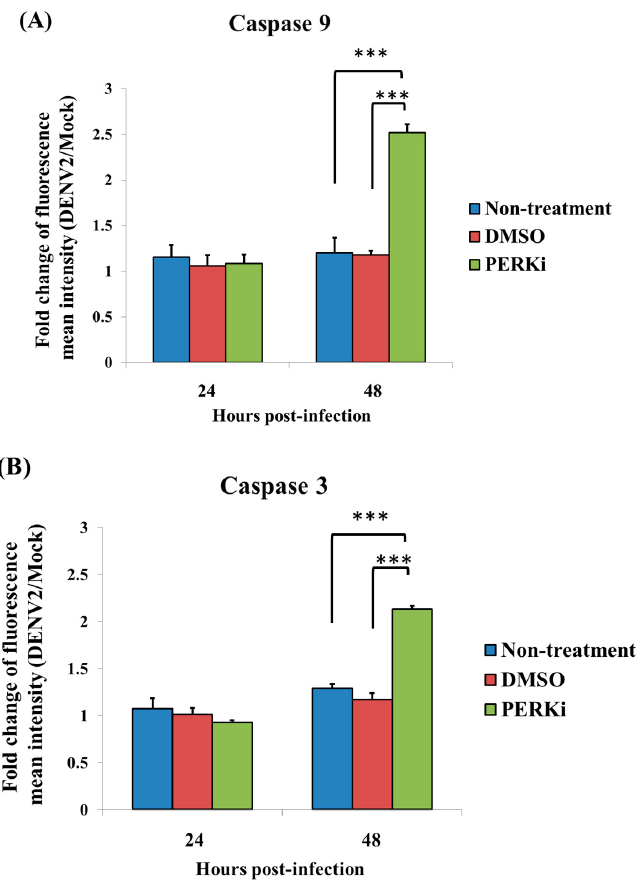
Figure 8. The effect of the PERK inhibitor on activation of caspases-9 (the initiator) and -3 (the effector) in C6/36 cells with dengue 2 virus (DENV2) infection by using FACScan flow cytometry. ( A ) In DENV2-infected C6/36 cells (MOI = 1), no evident change in caspase-9 had occurred in cells by 24 h post-infection (hpi), even when they were treated with a PERK inhibitor (5 μ M). However, it had increased by 48 hpi (2.52-fold increase) compared to the two control groups (1.20- and 1.18-fold for untreated and DMSO-treated cells, respectively; Student’s t -test; *** p < 0.001); ( B ) A similar changing trend of caspase-3 was seen in the same cell group, having remained unchanged at 24 hpi, but having significantly increased at 48 hpi (2.13-fold increase) compared to the control groups (1.29-fold for the untreated and 1.17-fold for the DMSO-treated group; Student’s t -test; *** p < 0.001). Very likely, the DENV2-induced PERK signaling pathway was important for C6/36 cells avoiding induction of apoptosis during infection.